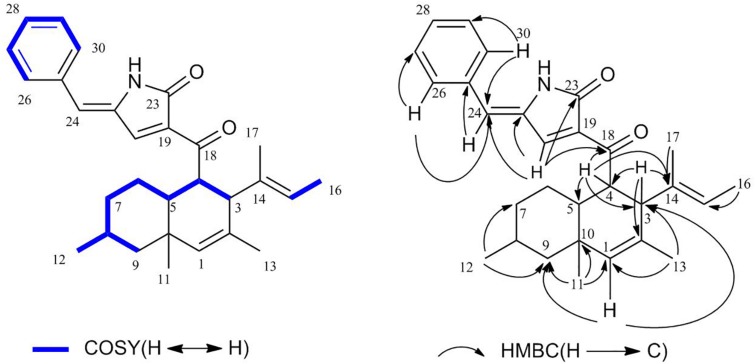
1H–1H COSY and Key HMBC correlations of 1.